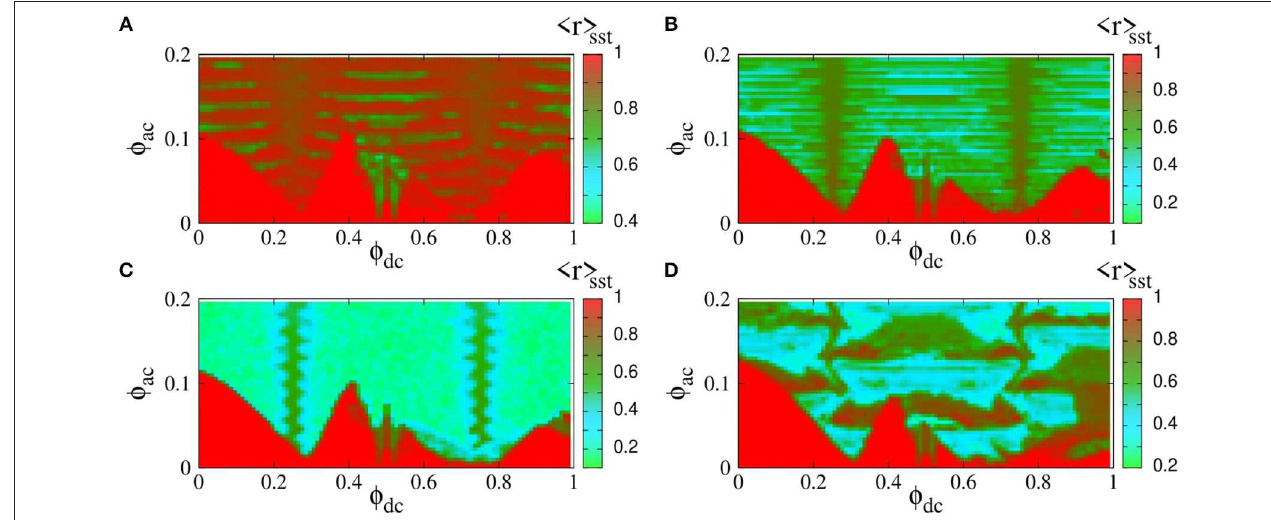
r , on the dc flux bias–ac flux amplitude h i sst 1.01, (D) (cid:127) 0.982. = =